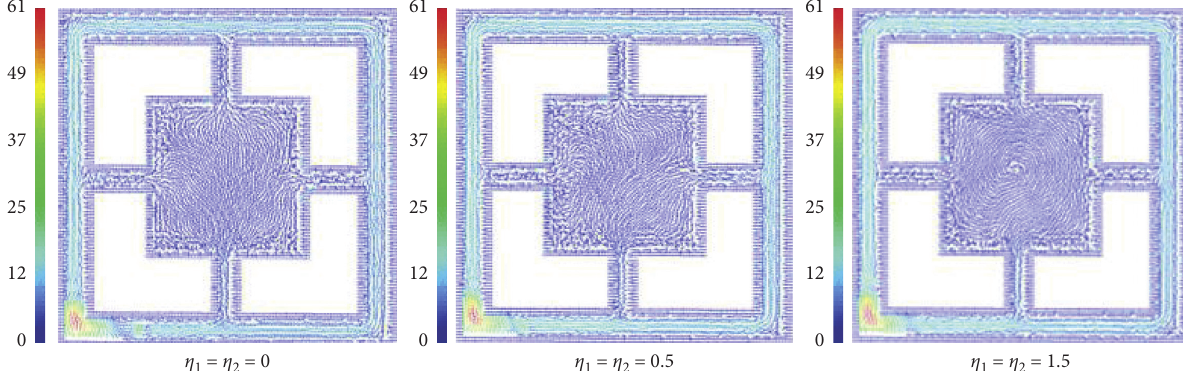
Figure 14: Features of concentration below the variations of a porous level, η Le � 20, and τ �